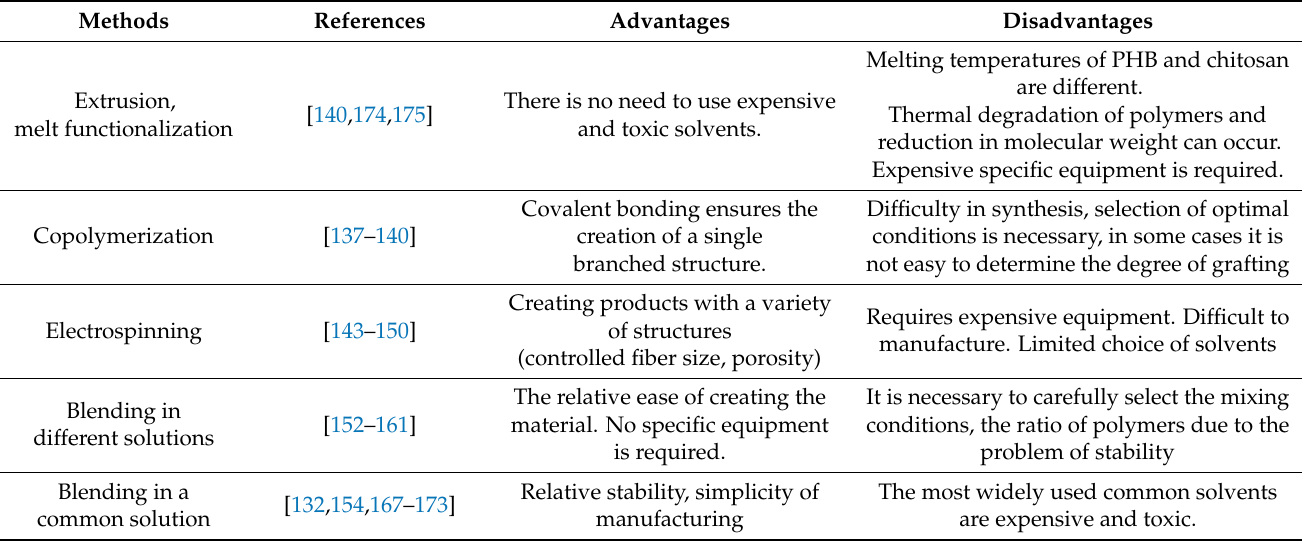
Table 4. Advantages and disadvantages of methods for creating